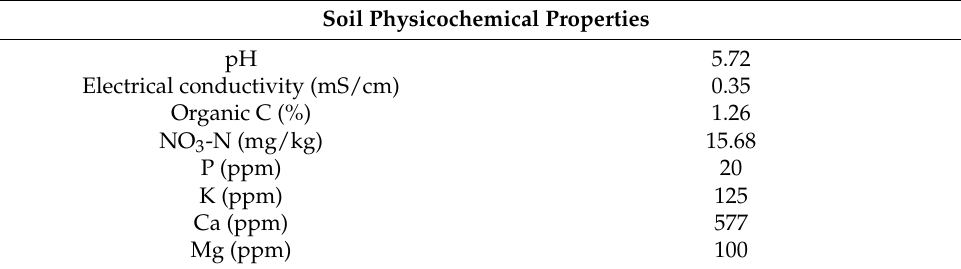
Table 1. Physicochemical characteristics of the soil used in our